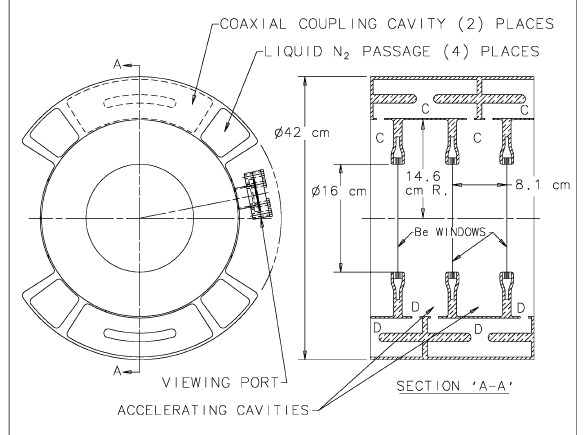
FIG. 34. Two full cell sections plus two half-cell sections of the interleaved p (cid:1) 2 mode accelerating cavities. The volumes labeled C are powered separately from the volumes labeled D.